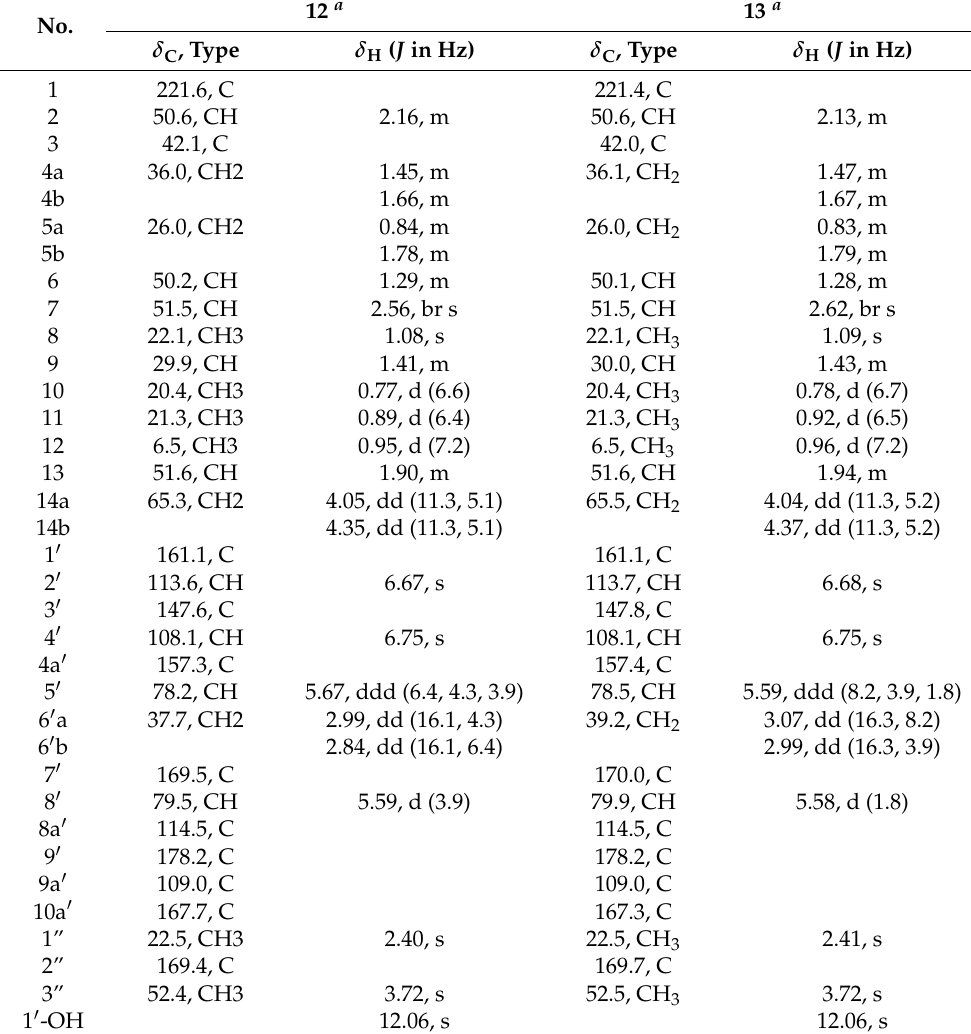
Table 5. 1 H (600 MHz) and 13 C (150 MHz) NMR Spectroscopic Data for 12 and 13